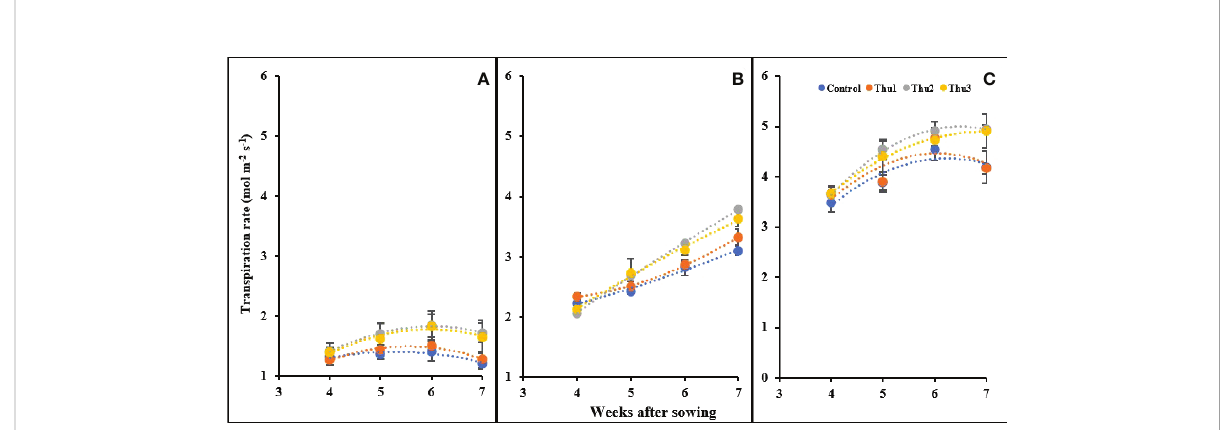
FIGURE 15 Changes in the transpiration rate under application of Th17 at low (A) , optimum (B) and high (C) temperature at 4, 5, 6 and 7 weeks after sowing. Thu1: 10 -7 M Th17, Thu2: 10 -9 M Th17, Thu3: 10 -11 M Th17. Each point represents mean ± standard error